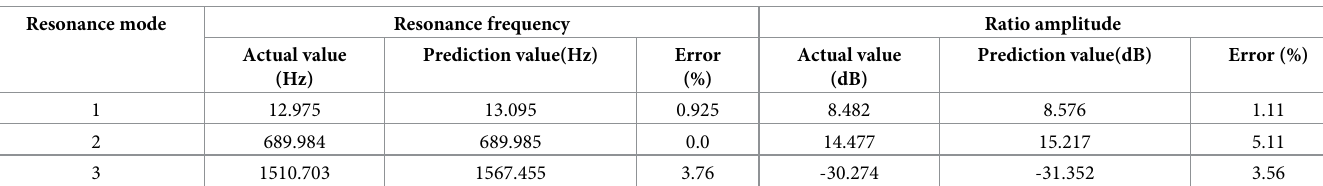
Table 5. Prediction of the resonant modes of the CVT with a speedy saturation damper. Resonance